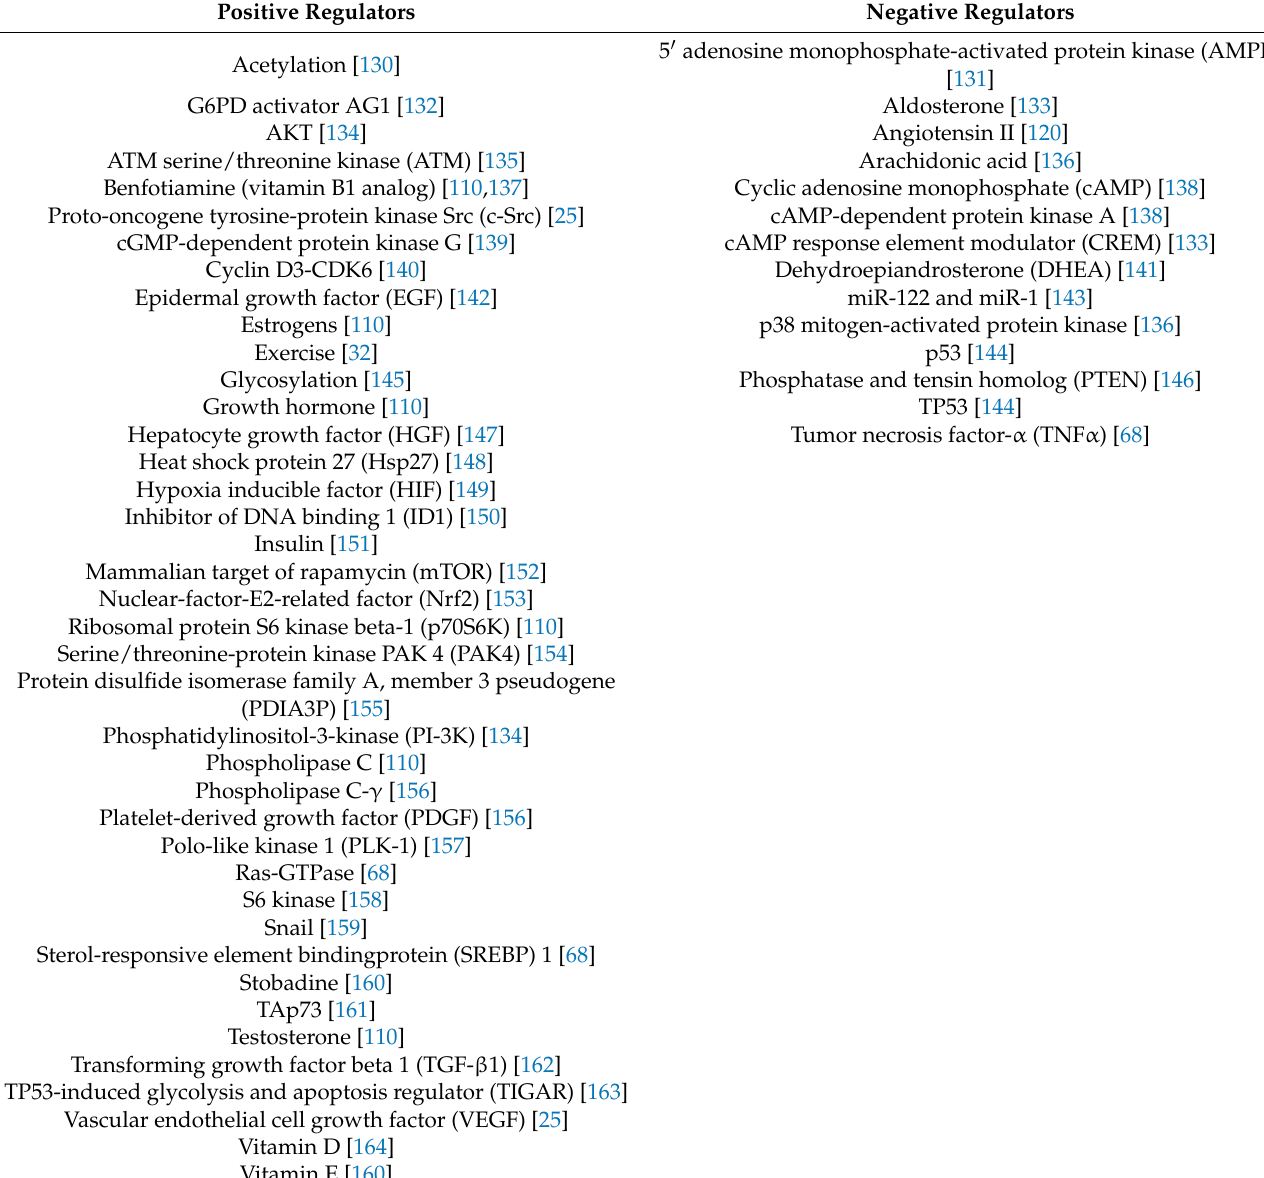
Table 2. Cellular signals regulating G6PD and the